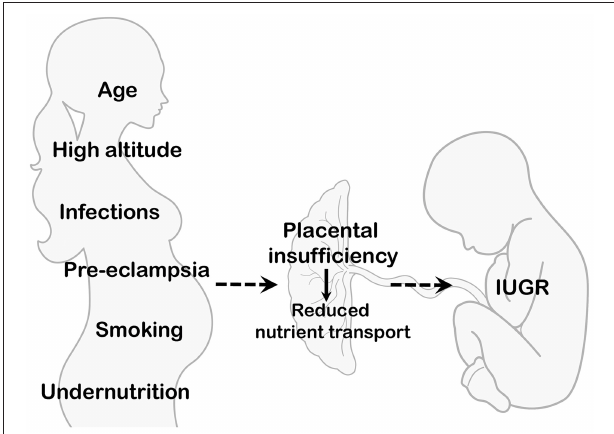
FIGURE 2 | Maternal and environmental conditions associated with IUGR. Several maternal/environmental conditions are associated with placental insufficiency and decreased delivery of nutrients to the developing fetus. Net placental transport is determined by multiple factors, such as uteroplacental and umbilical blood flows, placental exchange area and metabolism, as well as the activity and expression of placental nutrient